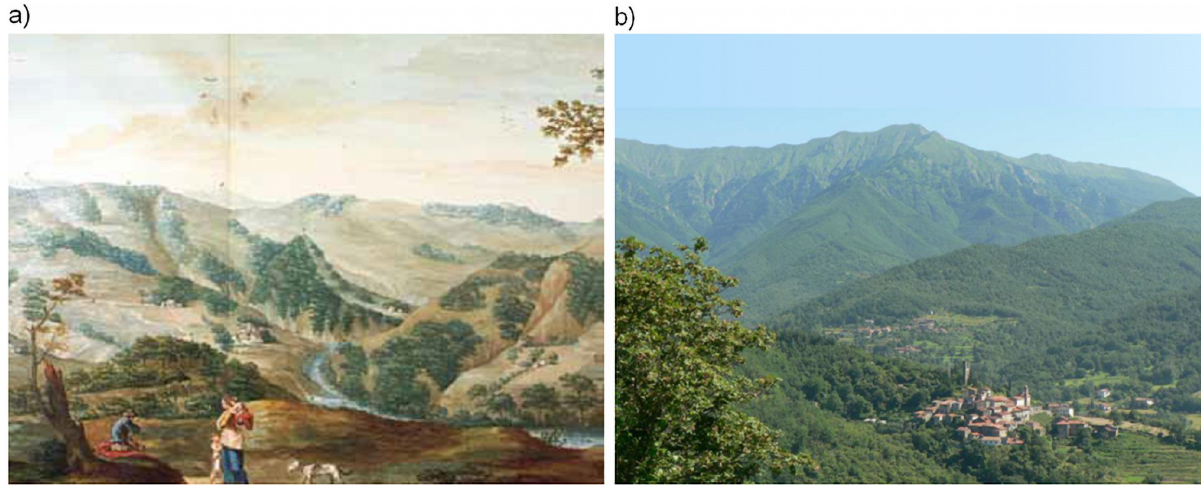
Fig 5. Environmental change along the history of Tuscany landscape. a) a view of upper Casentino with pastures and deforested mountains, c . 1780 by Pietro Ferroni (1745–1825) and collaborators [56]; State Archive of Florence, Italy, https://www.archiviodistato.firenze.it), b) Lunigiana mountainous landscape in a picture of Alberto Chiti-Batelli (born 1959), with medieval villages, terraced agricultural areas near the villages, chestnut woods, beech woods and summit meadows for summer grazing ([56]; source: Nature and Environment Management Operators, Florence, Italy, http://